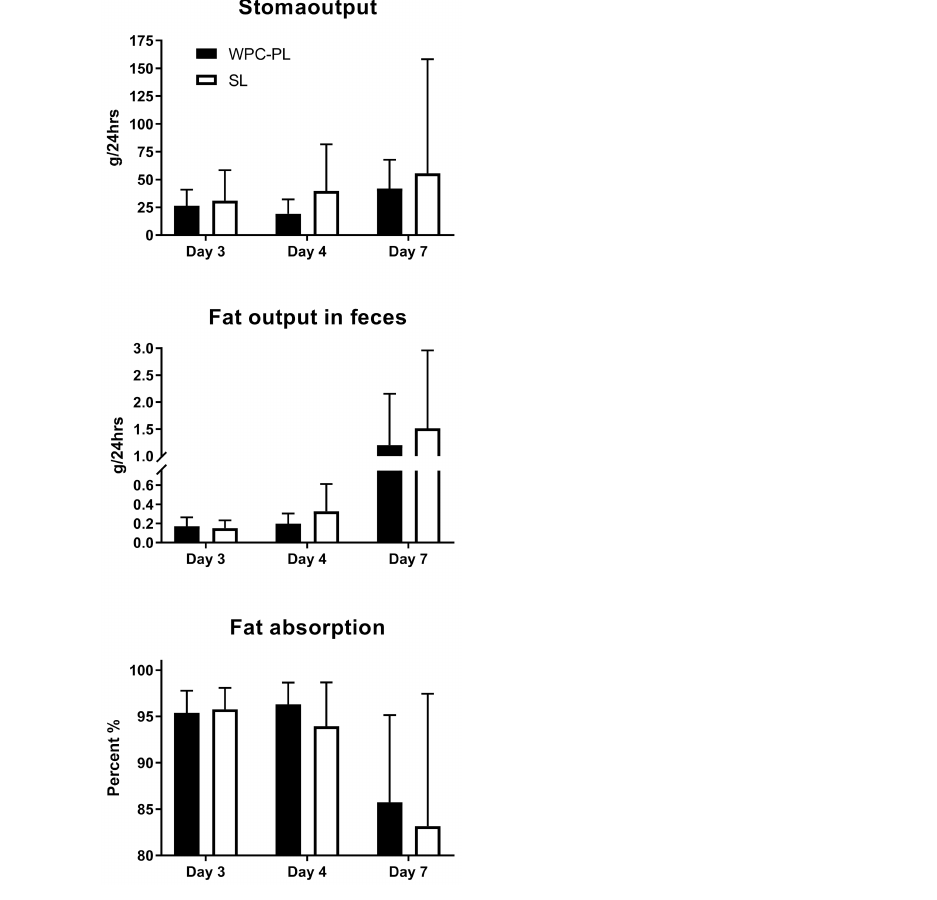
Figure 3. Total fecal stoma output (upper panel ), total fat output in the feces ( middle panel ) and fat absorption percentages ( lower panel ) on day 3, 4, and 7 (WPC-PL n = 6–9, SL n = 5–9). Values presented as mean ±